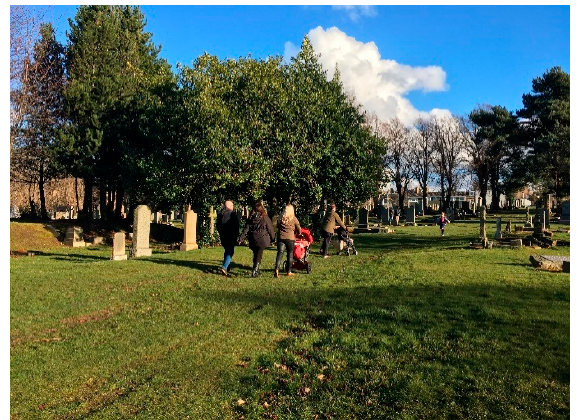
Figure 5. Dog walking at the Warriston Cemetery.